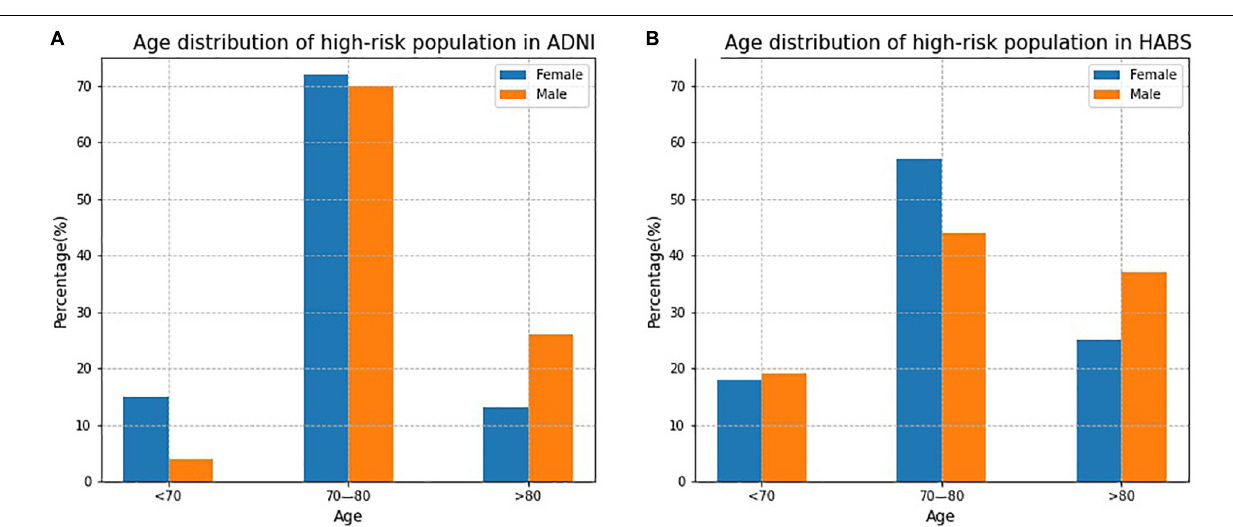
FIGURE 5 | The age distribution of high-risk participants predicted by the SRSS-CNMCI in ADNI and